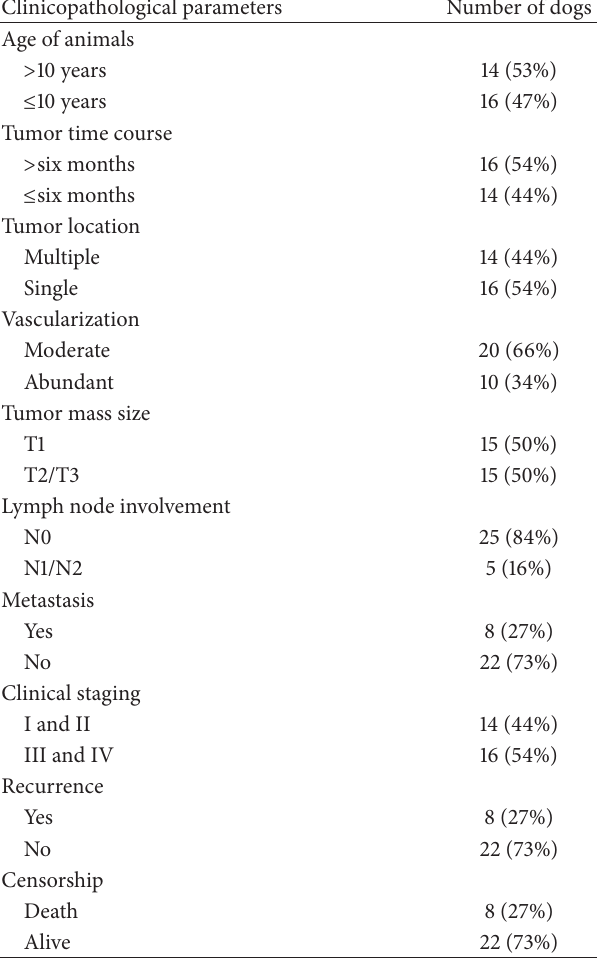
Table 1: Clinicopathological parameters of female dogs with mam- mary